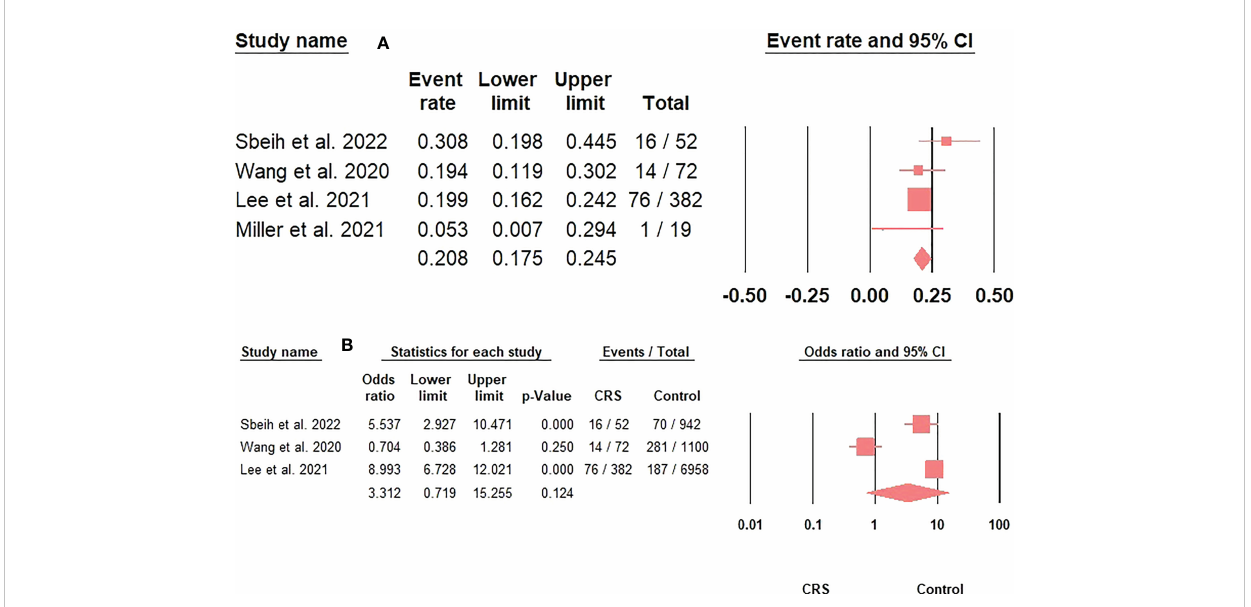
FIGURE 4 (A) . The prevalence of steroids/immunosuppressive therapy use in CRS patients with COVID-19 represented by the event rate and 95% con fi dence interval. Figure 4 (B) . The association between steroids/immunosuppressive therapy use in CRS patients and acquiring COVID-19 represented by the odds ratio and 95% con fi dence interval.